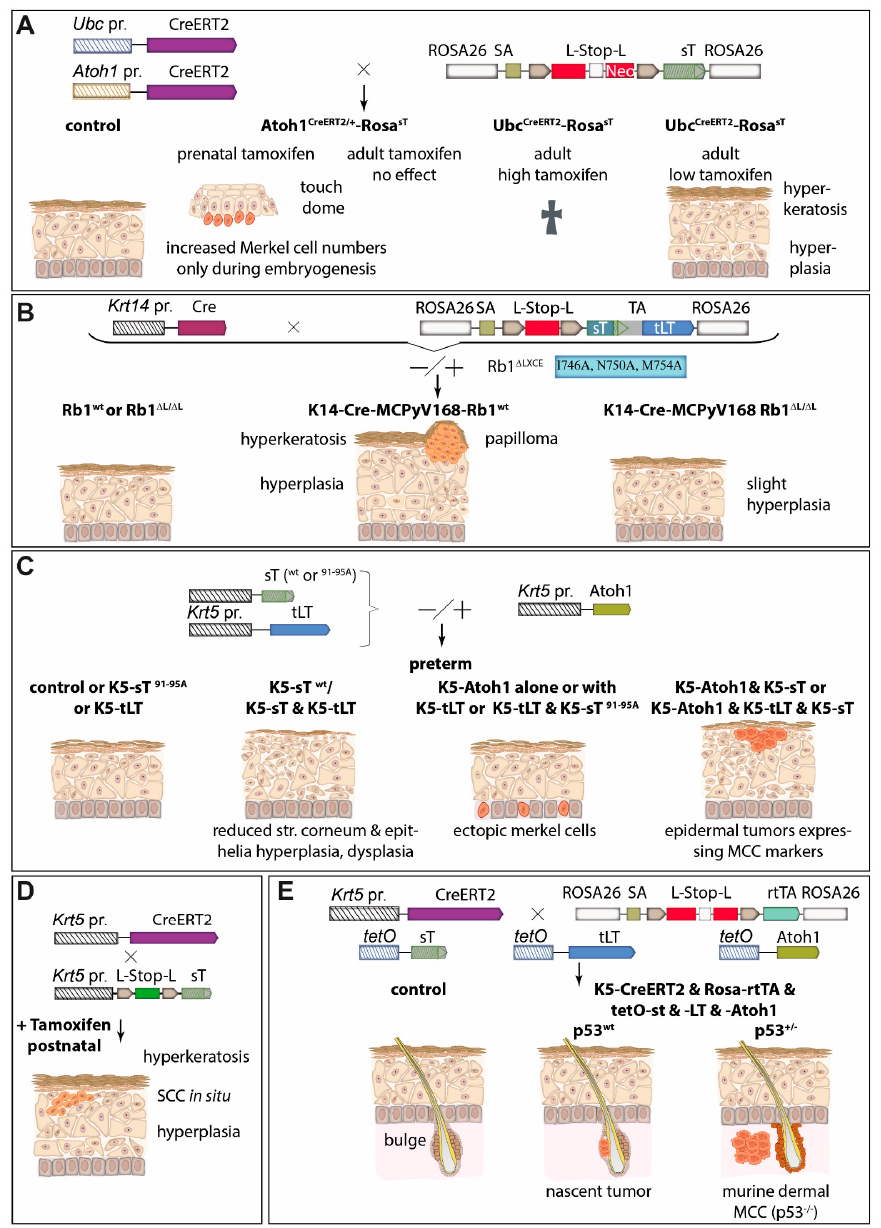
Figure 5. Of the different strategies tested, so far only the combined expression of T antigens and the transcription factor Atoh1 in a p53-deletion background can trigger MCC formation in a mouse